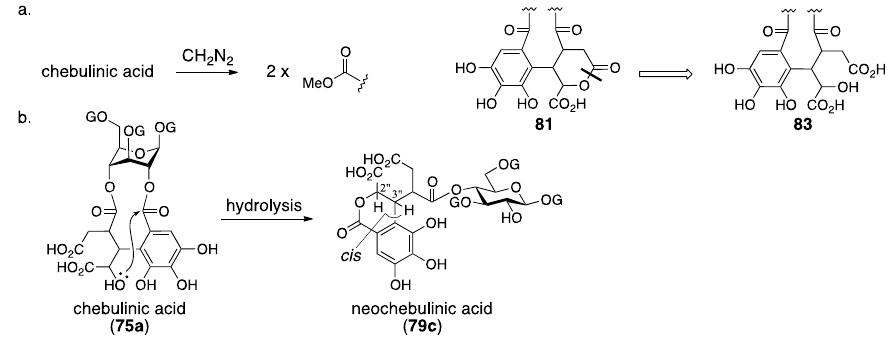
Figure 32. The consideration of the structural revision to the second structures of chebulinic acid and chebulagic acid. chebulagic